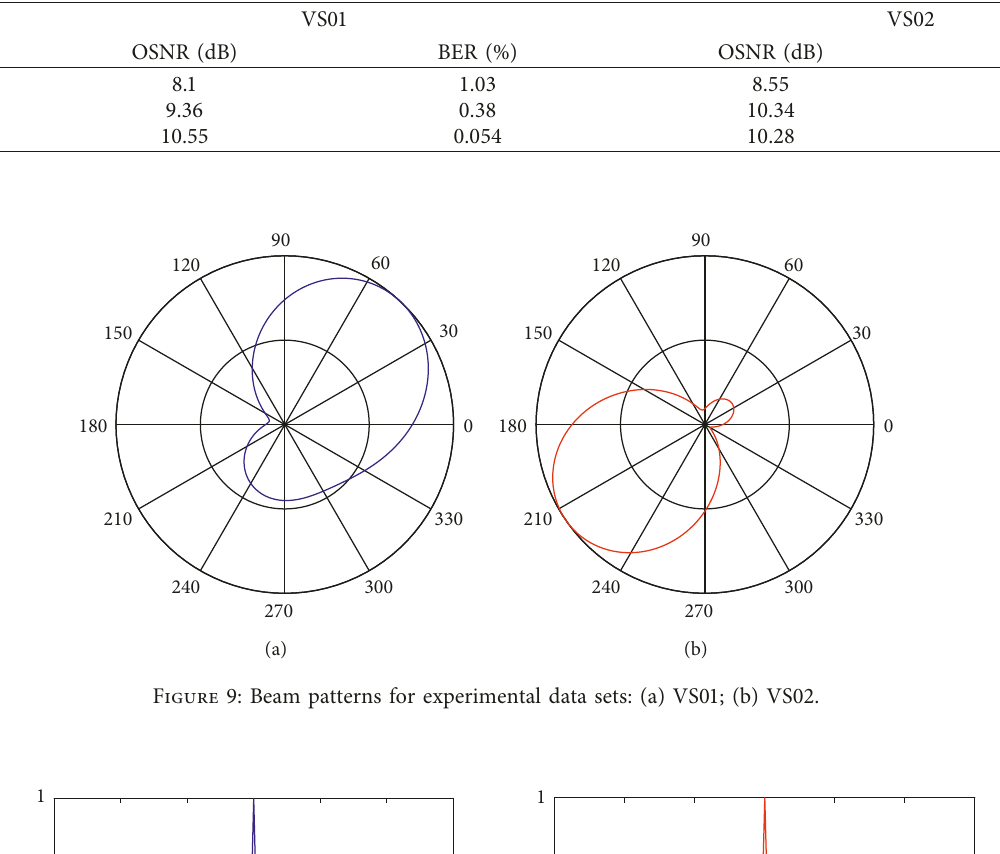
Table 1: Statistical OSNR and BER for the two data sets.